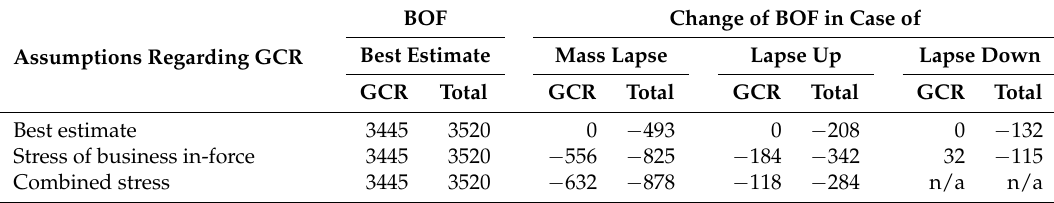
Figure 4. Pre-financing of acquisition costs over time for best estimate and mass lapse stress (in A C1000). Table 12. BOF and SCR under different stress assumptions regarding the GCR (in A